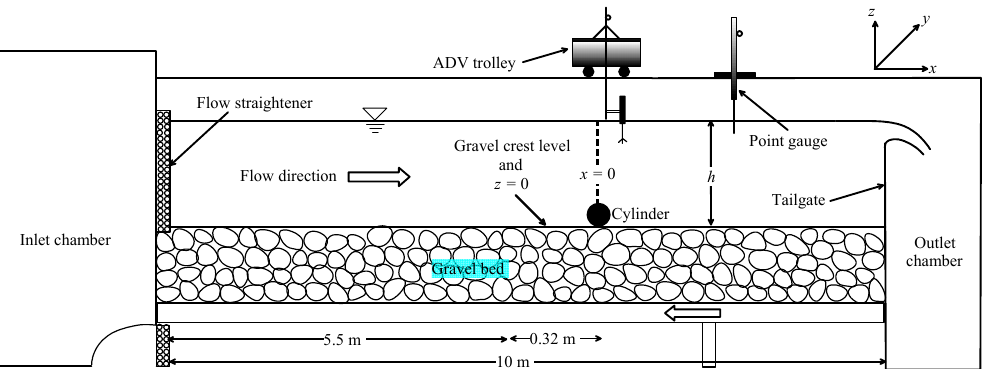
Figure 1. Schematic diagram of the experimental setup for the gravel-bed (GB 1).